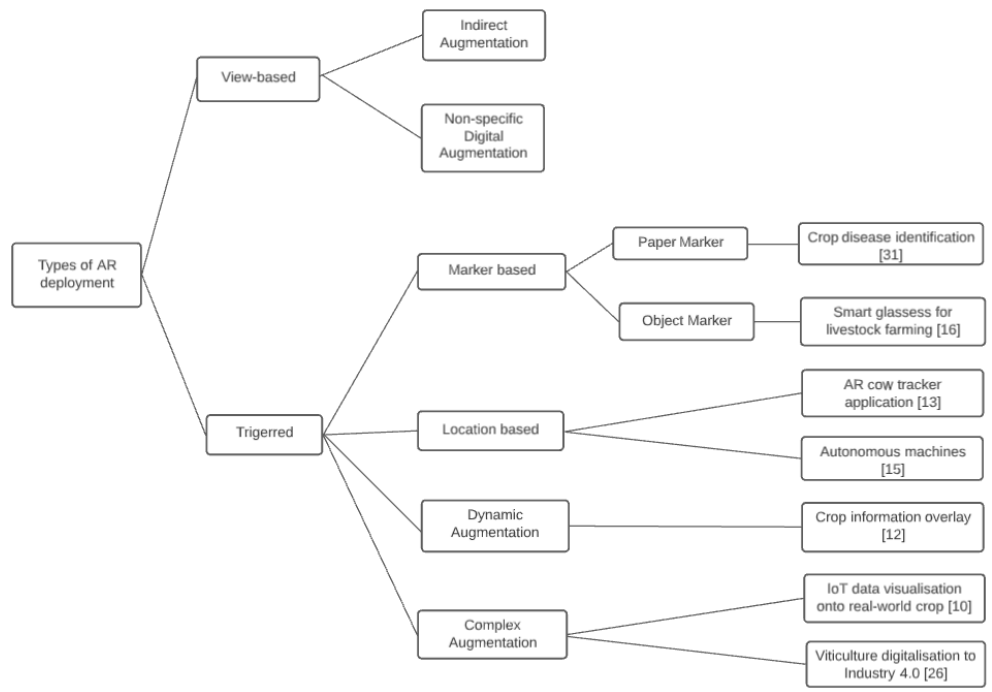
Figure 1. Types of AR deployment within crop and livestock management, adapted from the model in [32].